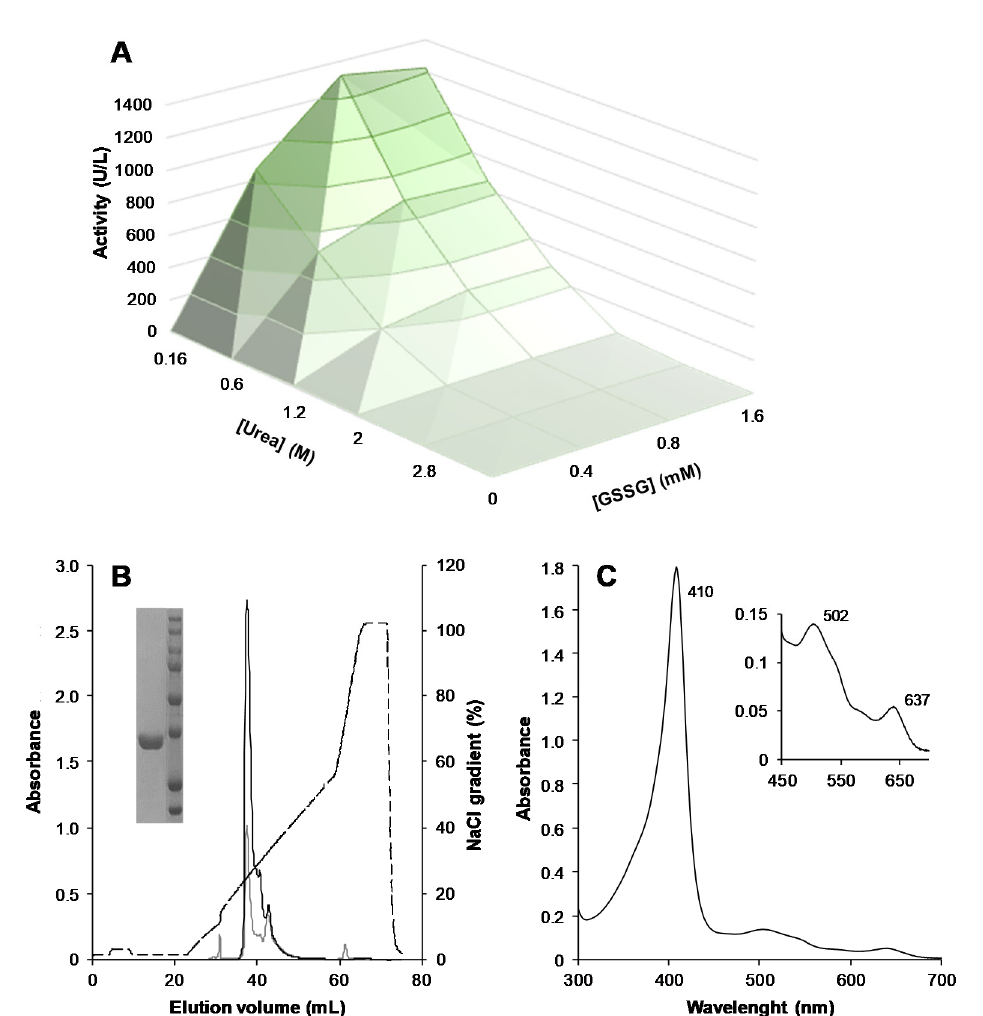
Figure 1. In vitro activation, purification, and electronic absorption spectrum of ApeLiP. ( A ) Screening of the optimal urea (0.16–2.80 M) and GSSG (0-1.6 mM) concentrations (by incubating 0.1 mg/mL protein in the presence of 0.1 mg/mL DTT, 0.02 mM EDTA, 5 mM CaCl 2 and 15 μ M hemin in 50 mM Tris-HCl, pH 9.0, at 4 °C during 24 h) as part of a multifactorial design. ( B ) Resource-Q chromatogram showing the elution profiles at 280 nm (gray line) and 410 nm (black line) and NaCl gradient (dashed line), with the inset showing SDS–PAGE of purified ApeLiP and molecular-mass markers (of 250, 150, 100, 75, 50, 37, 25 and 20 kDa, from top to bottom). ( C ) UV-visible spectrum of the enzyme at the resting state, with indication of the Soret band (410 nm) and CT1 (637 nm) and CT2 (502 nm) charge-transfer bands (inset).